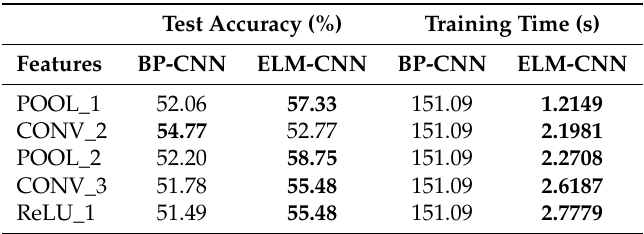
Table 3. Features performance comparison between ELM-CNN and BP-CNN on the VAIS dataset (Small